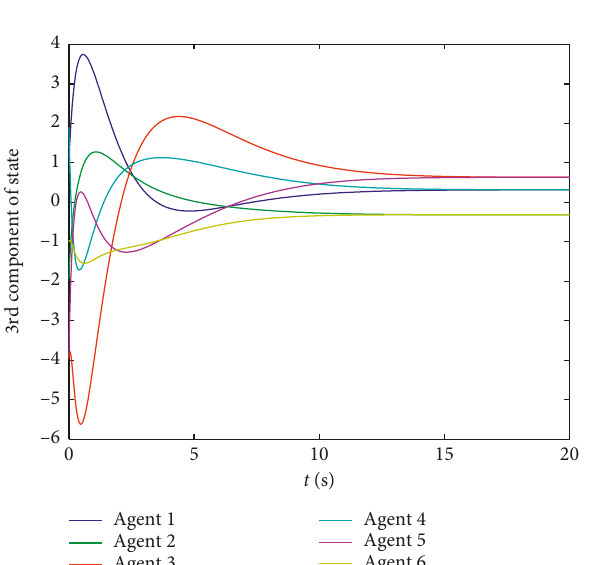
i, 2 via protocol (13).